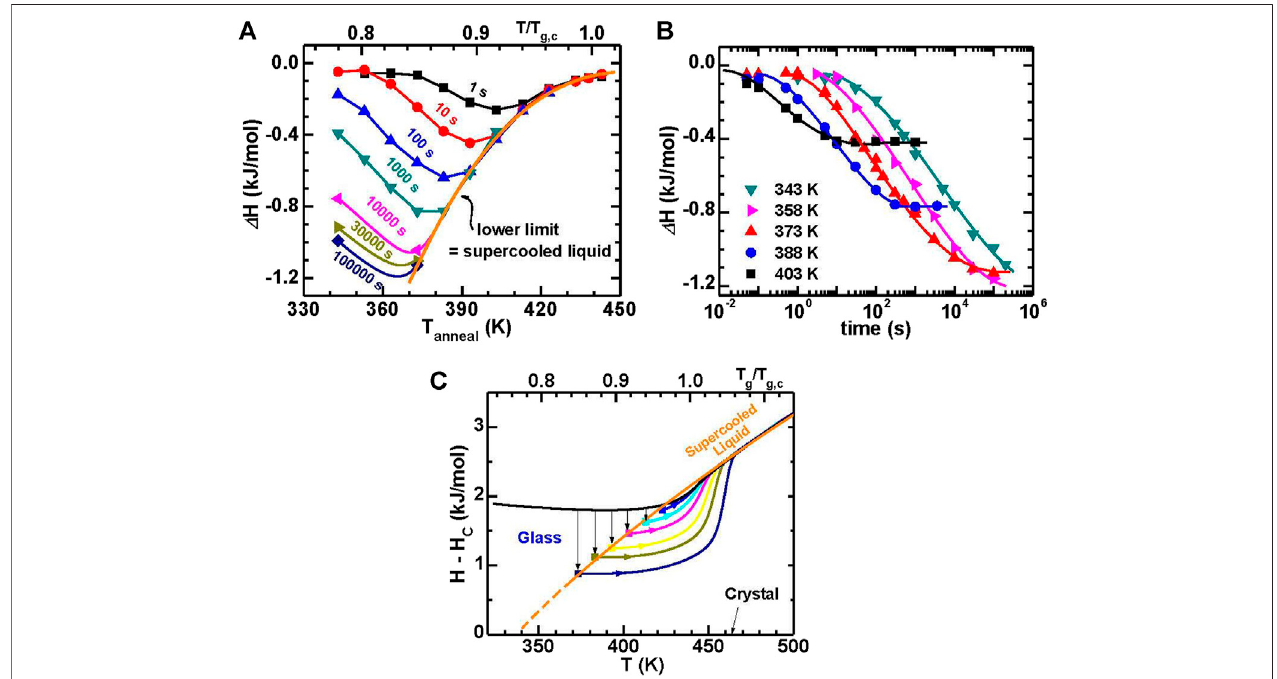
FIGURE 11 | (A) The enthalpy decrease ( Δ H ) for a Au 49 Cu 26.9 Ag 5.5 Pd 2.3 Si 16.3 glass with different annealing temperatures at constant annealing times. (B) The Δ H along with annealing time for the glasses annealed at fi ve representative temperatures. (C) Enthalpy evolution with temperature for fully-relaxed glasses marked by solid symbols.Theevolutionpathsfallsontotheextrapolationcurveofthesupercooledliquidenthalpy.Forcomparison,theenthalpieswithtemperatureduringheatingforthe fully-relaxed glasses are shown as solid curves. The enthalpy for the as-cast glass marked by black curves is also displayed (from (Wang et al., 2016)).